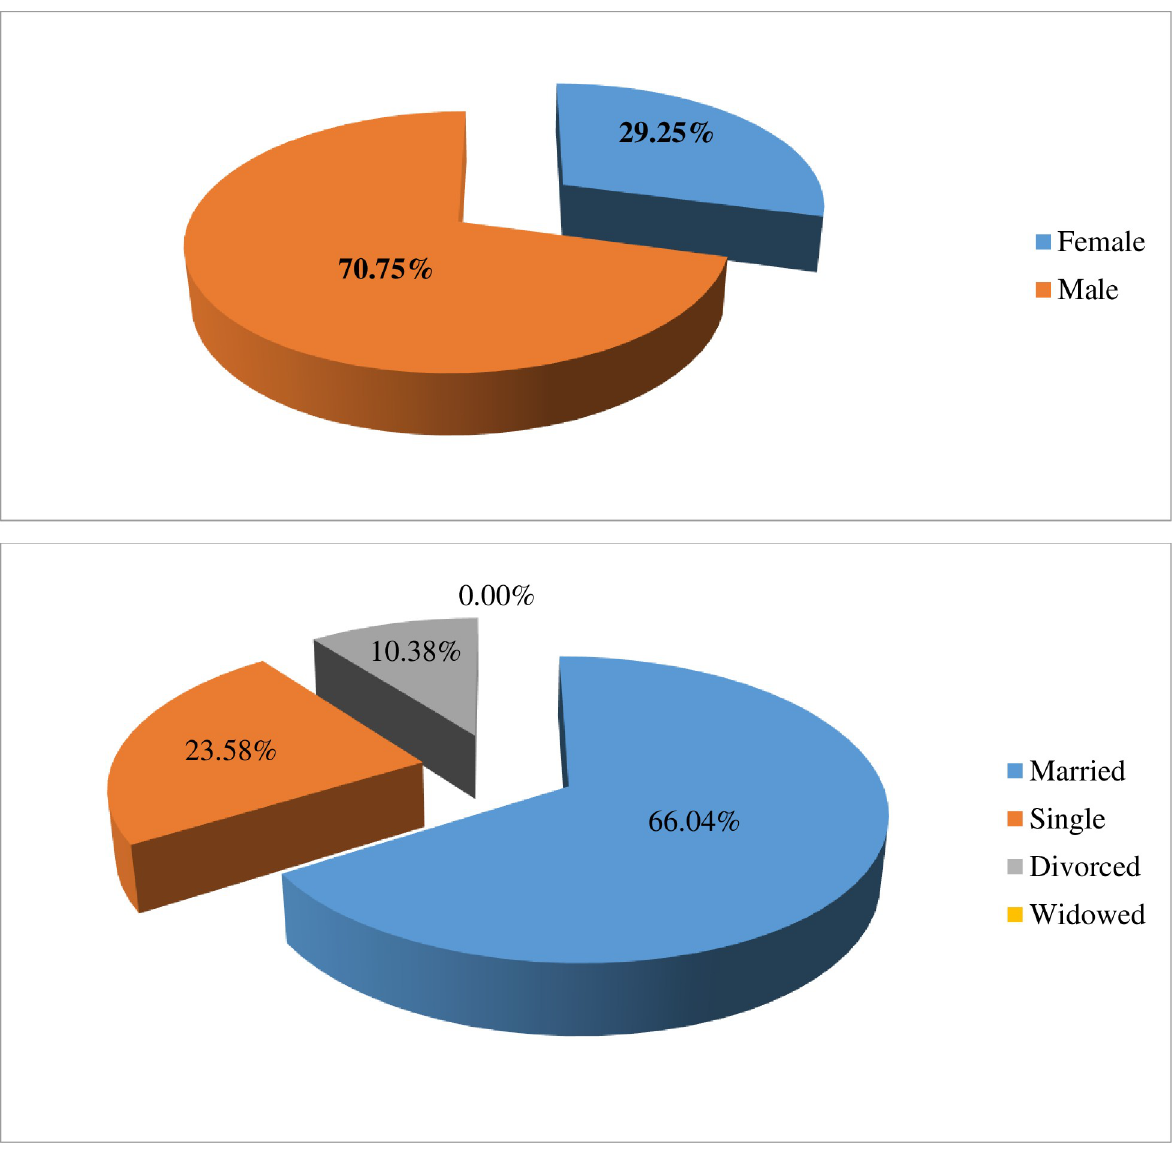
Fig 1. Demographic characteristics of sample households.